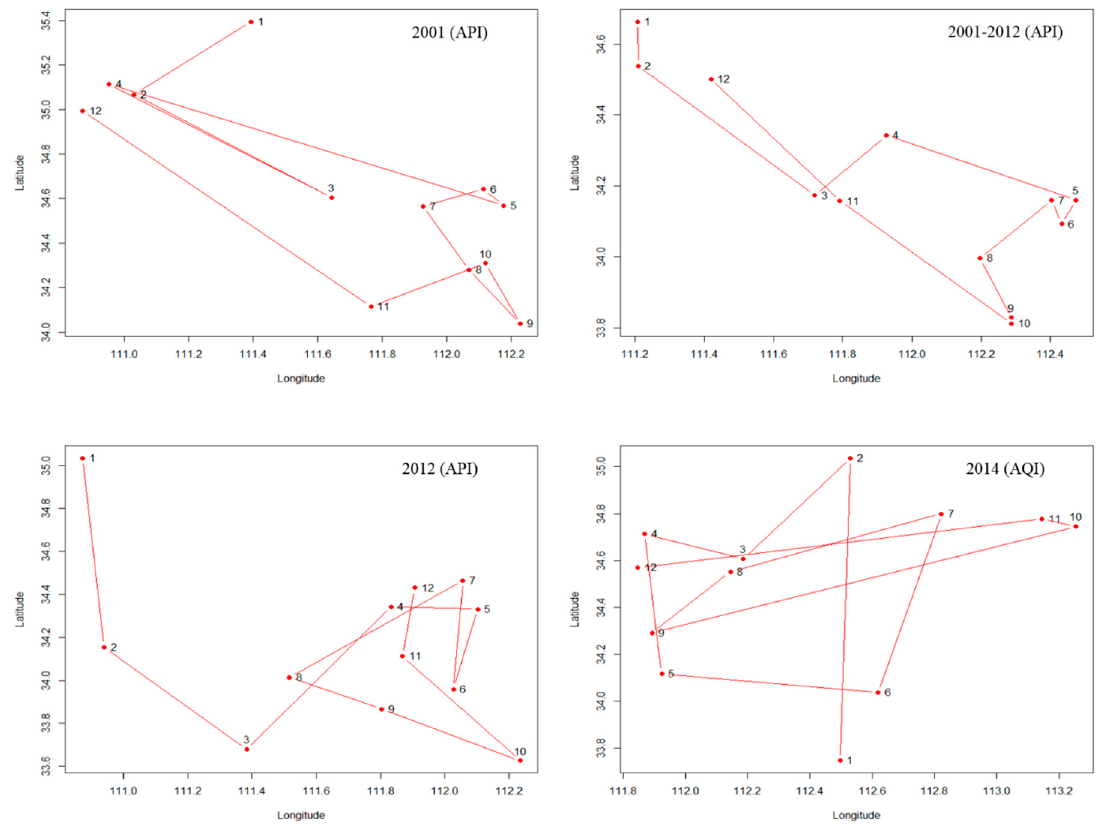
Figure 7. The shifts of the API and AQI gravity centers in different months.